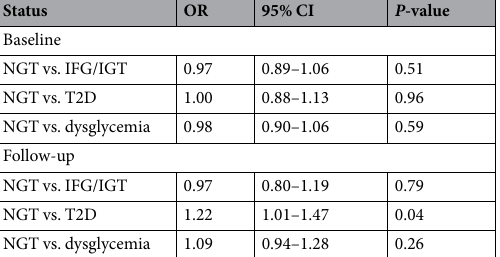
Table 2. Association between depression and T2D-related traits at baseline and follow-up. Logistic regression models were adjusted for sex, age, BMI and ethnicity.